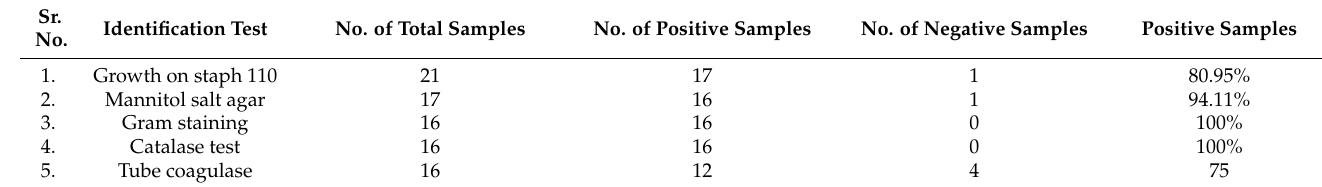
Table 2. Microbiological identification test results of milkers’ nasal S. aureus